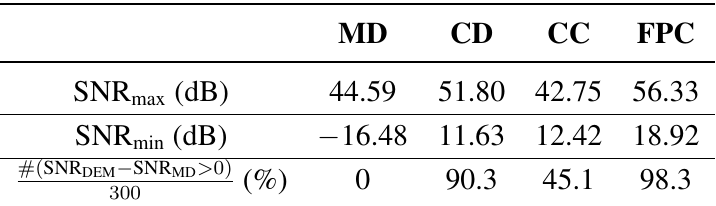
Figure 4. Comparison of the performance based on the variation of the obtained SNRs with the number of simulated scenarios. The SNR levels of CD, CC and FPC are compared with those of the MD algoritm ( upper-row ) and among each other ( bottom-row ). The CC performs better for low-amplitude vibrations (Scenarios 101–200; ∆ λ upper-center , bottom-center , bottom-right ). In all other cases, the FPC produces better results than the other algorithms.